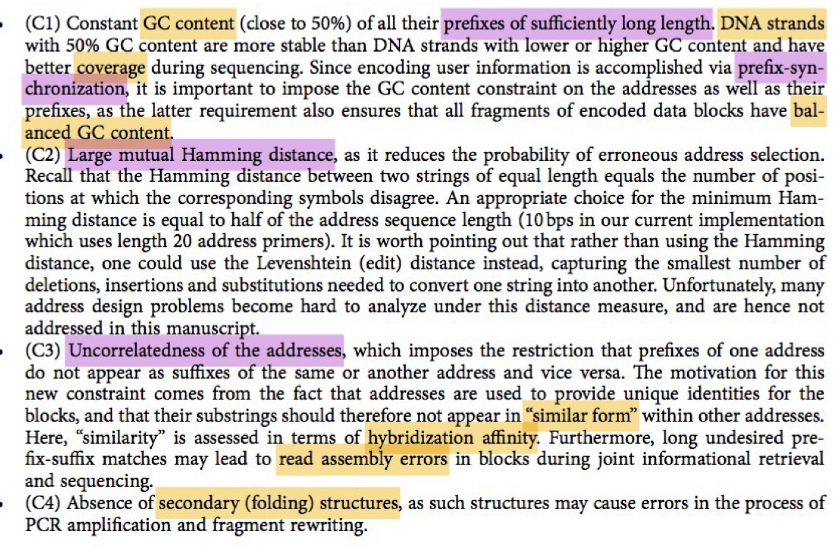
Figure 1. Sample paragraphs from 4. Terms that may not be clear to non-specialists in particular fields are highlighted in purple and yellow, corresponding to those causing problems for a molecular biologist and an information theorist, respectively. (Used under the